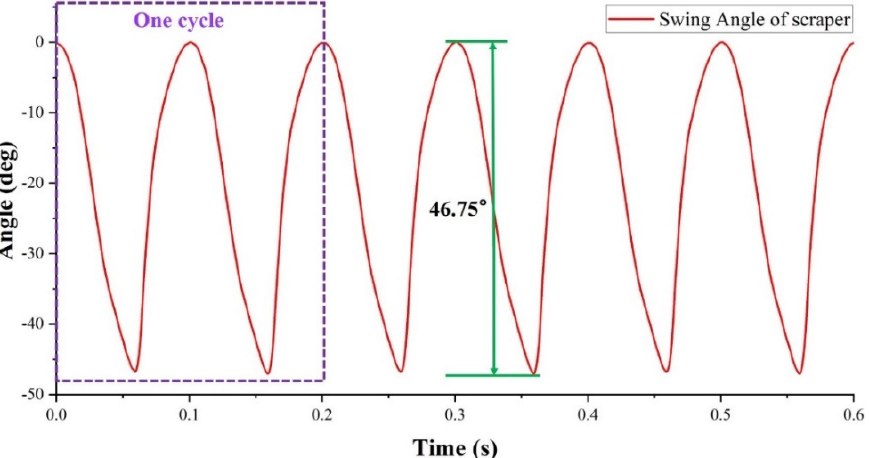
Figure 4. Swing scraper rotation angle curve.